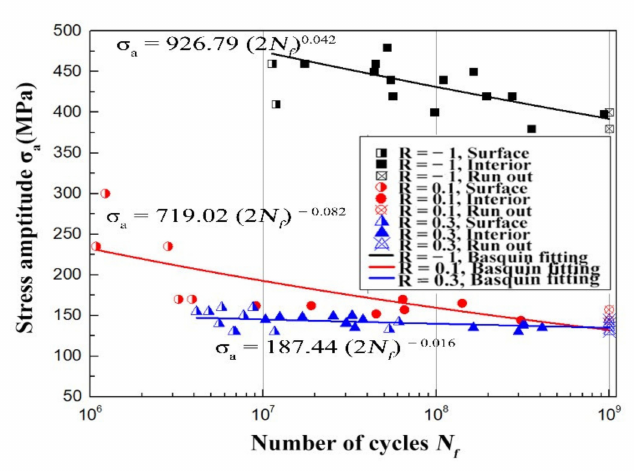
Figure 6. S-N diagram at R = − 1, 0.1 and 0.3.